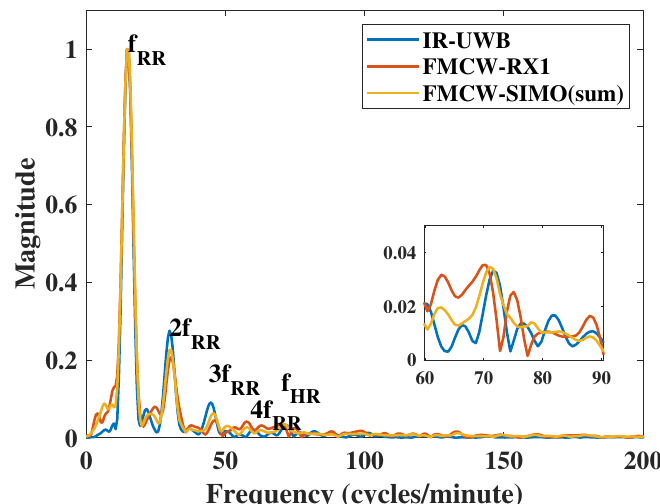
Figure 9. Measurement results with harmonic.